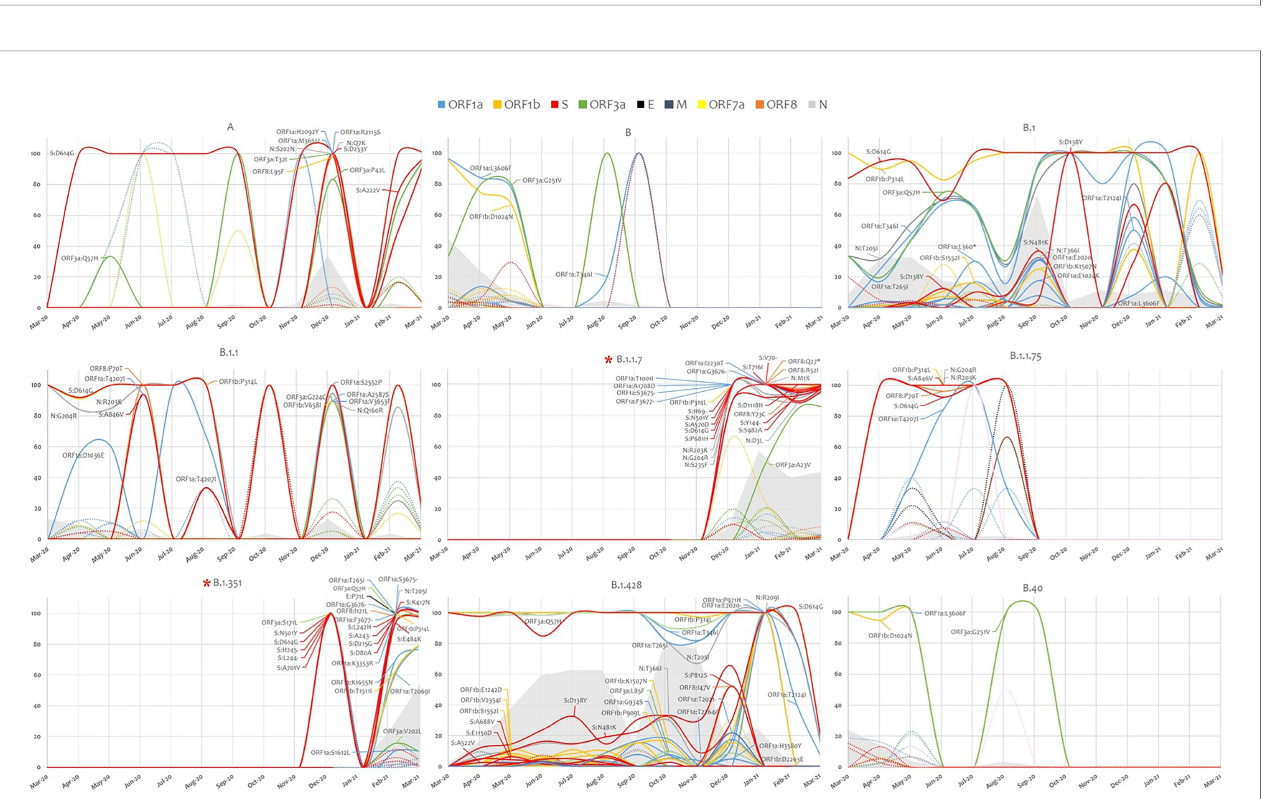
FIGURE 3 | SARS-COV-2 lineage speci fi c mutation analysis. Mutation in highly prevalent lineages are presented based on their prevalence. In solid lines, mutations that were detected at a frequency of at least 1% from the study cohort. Mutation in dotted lines did not pass the 1% cutoff in the study cohort but were present in at least 1% of the sequences in a particular lineage. The grey area represents the evolution of each lineage across the studied period. Variant of concern are identi fi ed with asterisk.